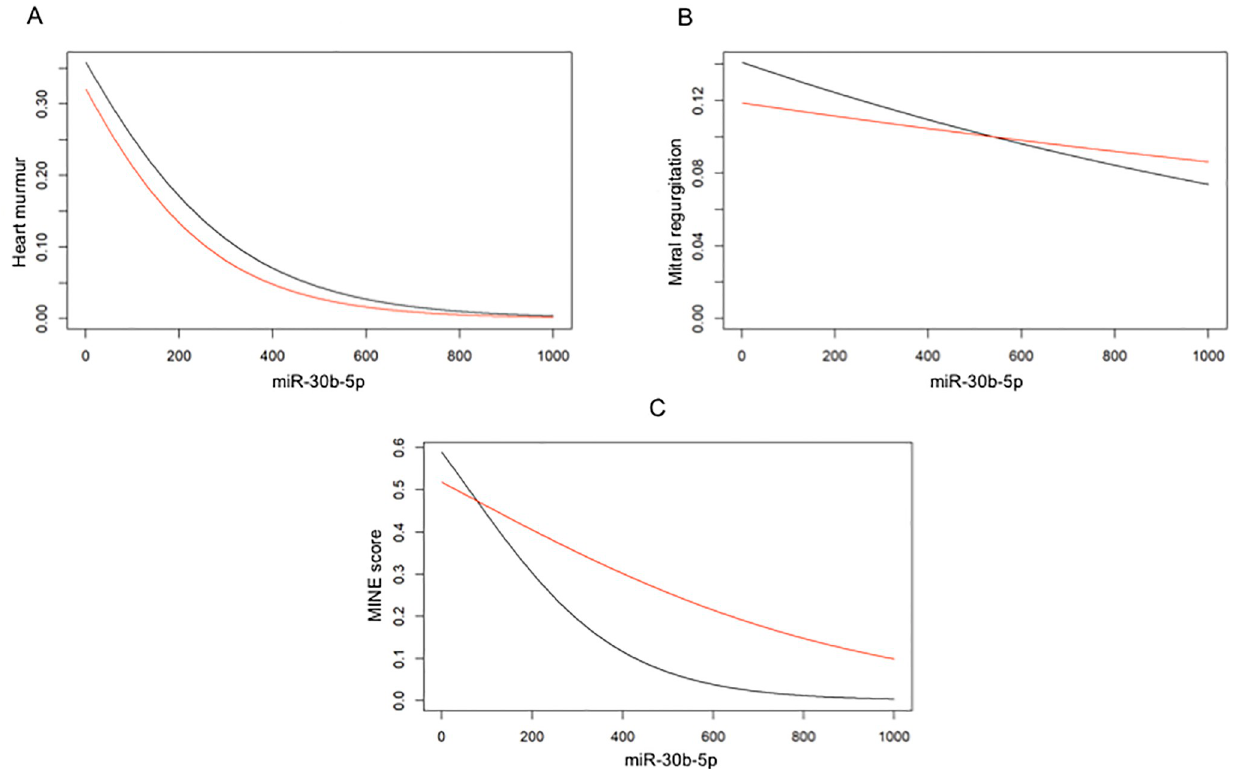
Fig 2. Marginal effect of plasma miR-30b-5p expression on ordinal variables at T0 and T1. Black line: T0. Red line: T1. On the y-axis, the probability of the class with the lower value is reported. A) Marginal effect of miR-30b-5p on the presence/intensity of a heart murmur. B) Marginal effect of miR-30b-5p on the mitral regurgitant jet size. C) Marginal effect of miR-30b-5p on the MINE score.